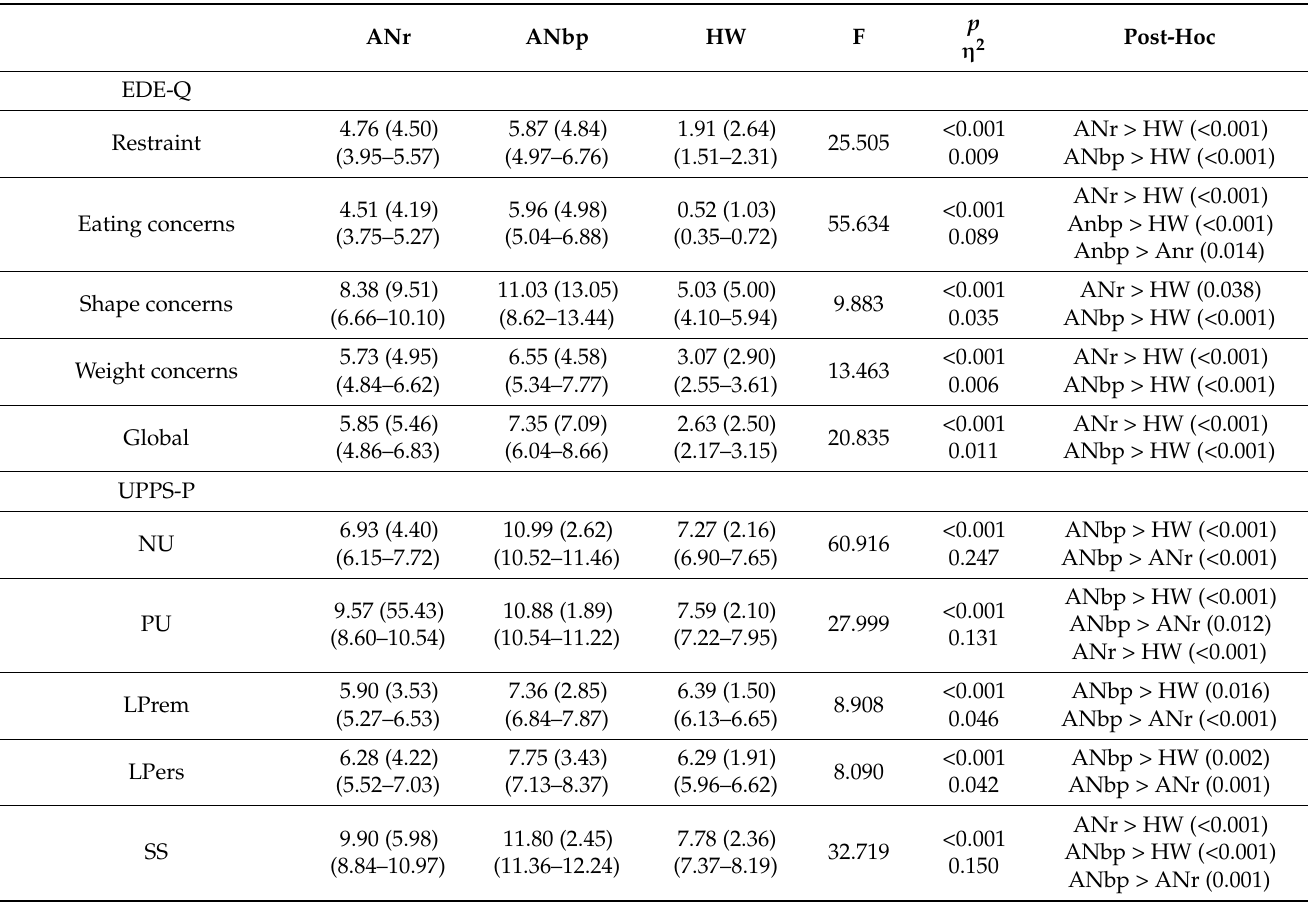
Table 2. Psychological evaluation of the sample.